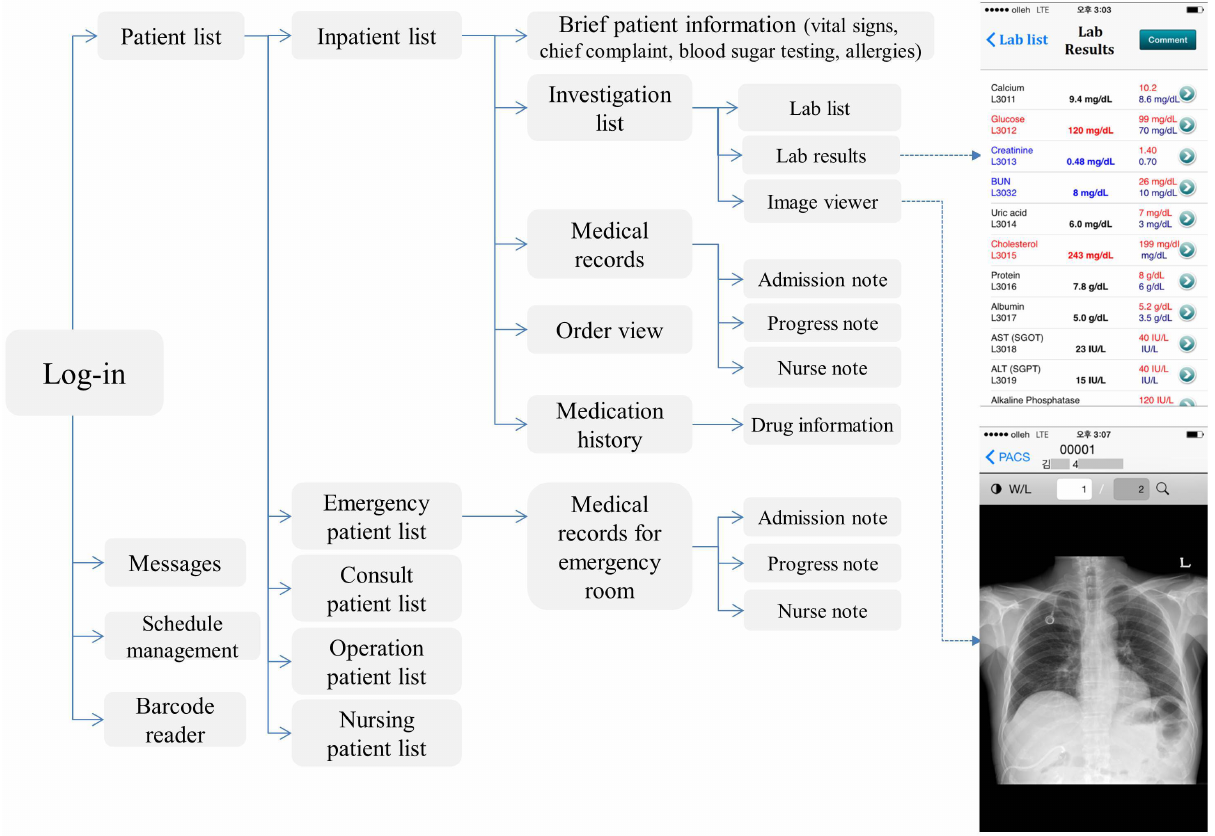
Figure 1. Function list and screen captures of the mobile Asan Medical Information System application. This application includes functions that allow viewing of all medical records, including medications, laboratory results, and images of radiologic